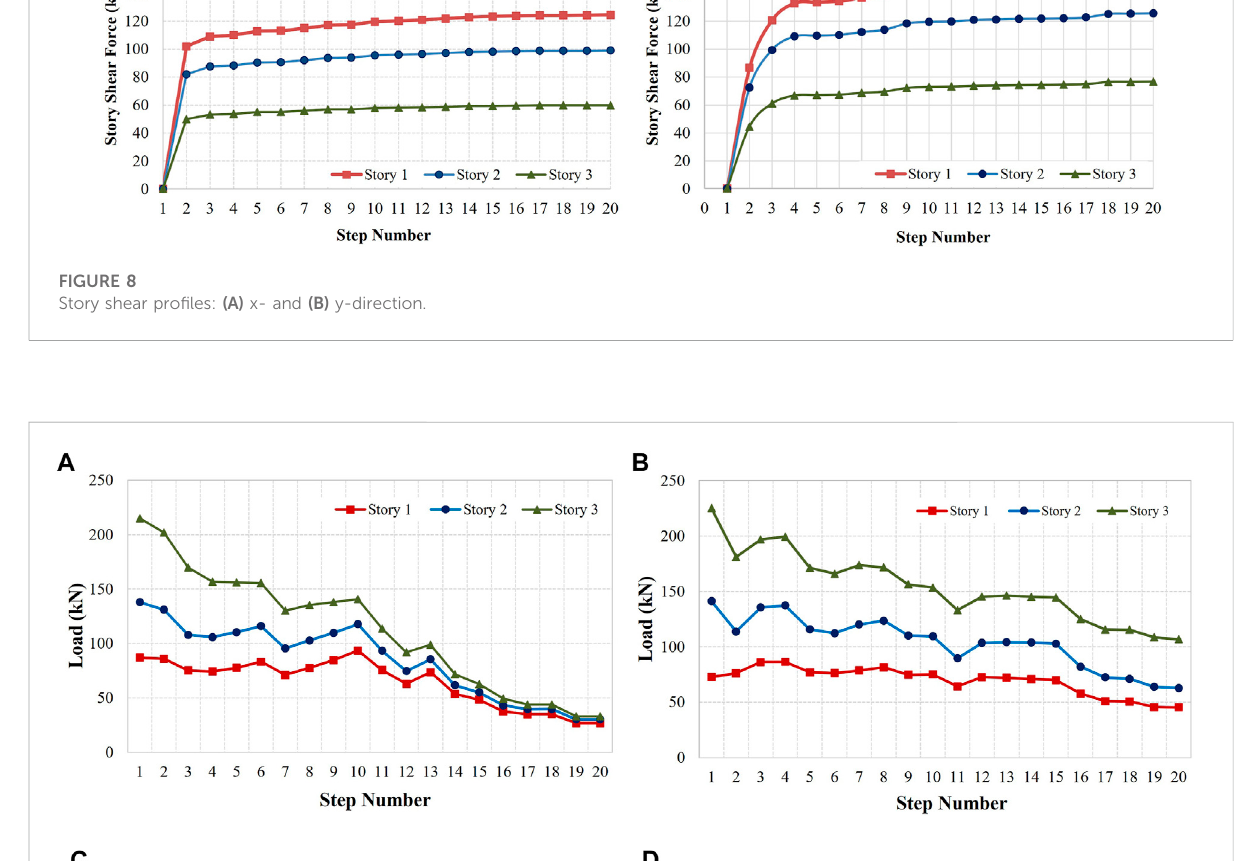
Frontiers in Built